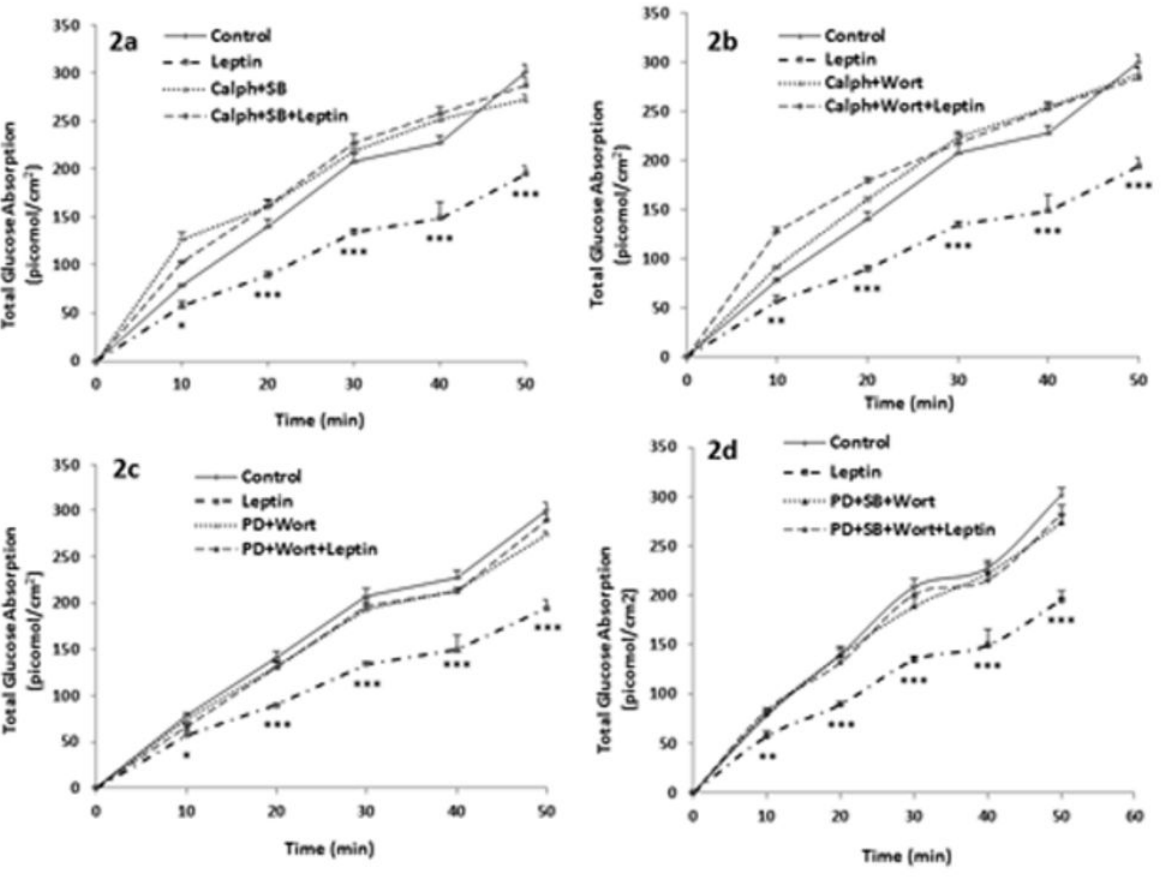
Figure 2. MEK/ERK, p38MAPK, PI3K and PKC act along the same pathway. Effect of leptin (10 nM) on glucose absorption by Caco-2 cells in presence and absence of (a) Calphostin C + SB202190, inhibitors of PKC and p38MAPK respectively, (b) Calphostin C + Wortmannin, respective inhibitors of PKC and PI3K, (c) PD98059 + Wortmannin, inhibitors of MEK/ERK and PI3K respectively, (d) PD98059 + SB202190 + Wortmannin, respective inhibitors of MEK/ERK, p38MAPK and PI3K. Absorption of glucose was measured at 10-min intervals over a period of 50 min. Values are means ± SEM of 5 observations. * P<0.05, **P<0.01, ***P<0.001: significantly different from all other